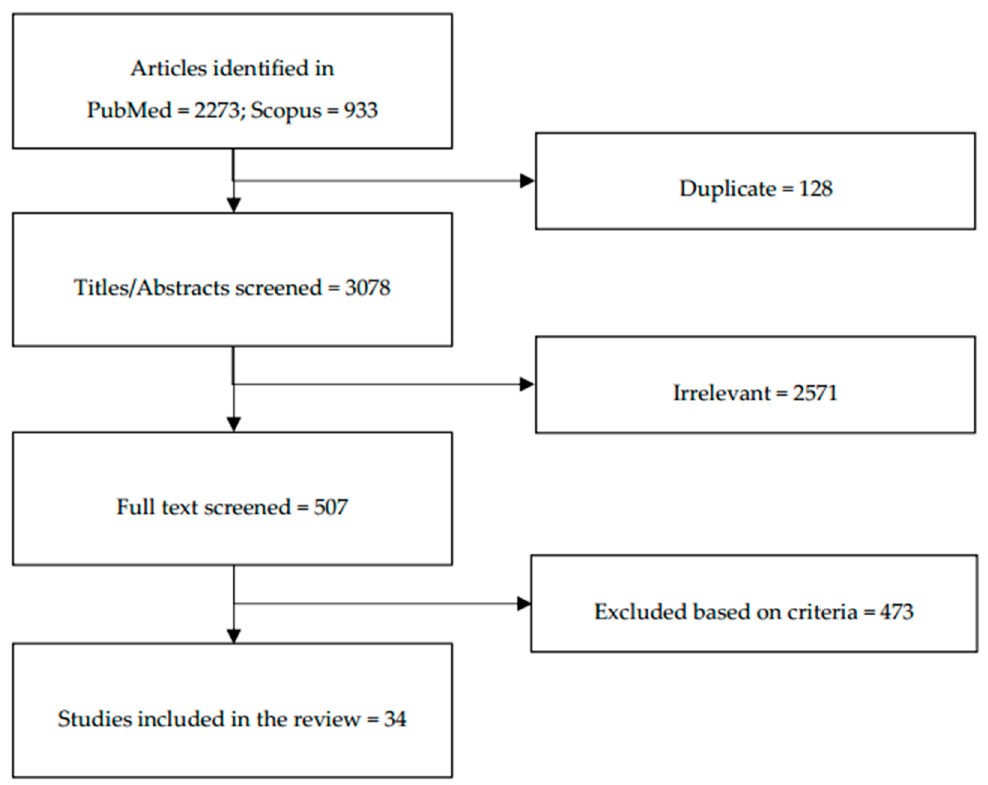
Figure 1. Flow diagram of the stepwise selection of relevant studies.